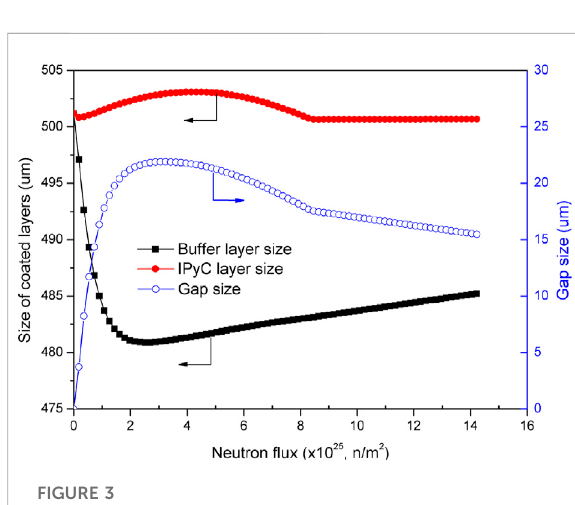
FIGURE 3 Dimensional variation of the kernel and coated